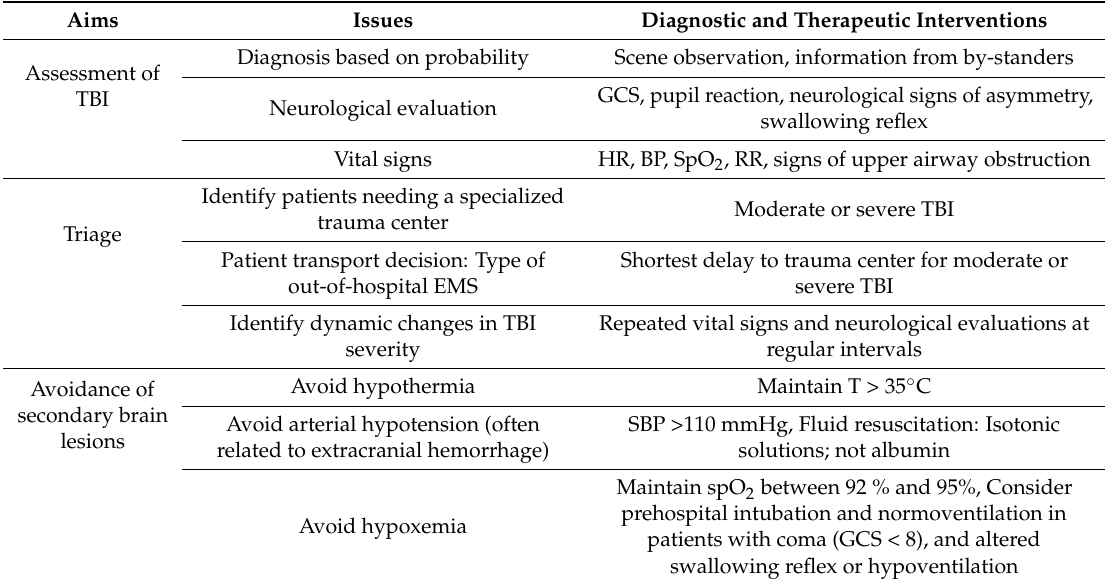
Table 2. Main missions and interventions of prehospital TBI